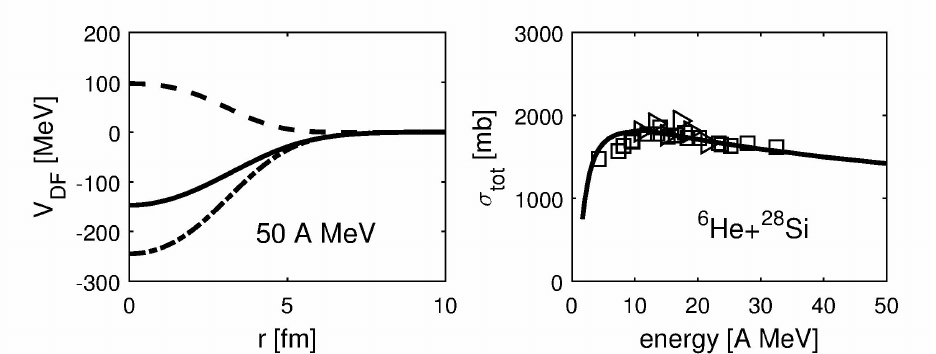
Figure 2. Left: The potentials V D (dashed), V EX (dash-dotted), and V DF (solid) of the 6 He + 28 Si scattering at 50 A MeV. Right: The energy dependence of the 6 He + 208 Si total reaction cross sections. Experimental data from [9] (squares) and [10]